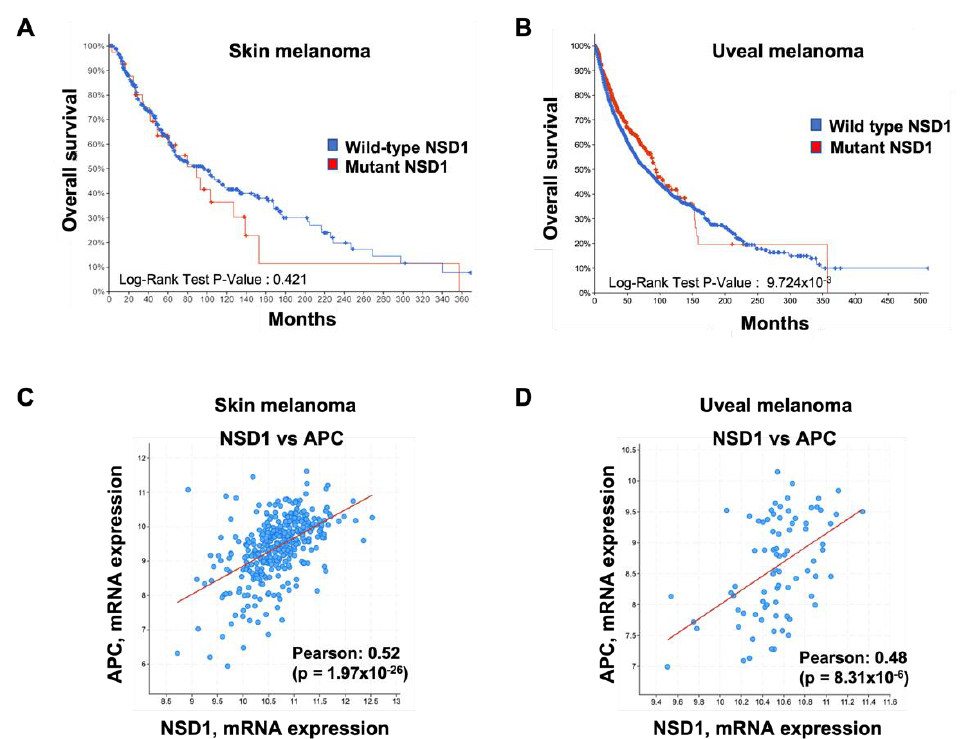
Figure 3. NSD1 mRNA expression in Uveal melanoma vs. Skin melanoma. ( A , B ) Kaplan–Meier curves showing overall survival stratified by NSD1 expression in ( A ) skin melanomas and ( B ) uveal melanomas (SKCM and UM-TCGA, respectively, cBioPortal.org). The log-rank test was used for statistical analysis. ( C ) Scatterplot showing NSD1 and APC mRNA expressions obtained from a skin melanoma cohort (cBioPortal.org). ( D ) Scatterplot showing NSD1 and APC mRNA expressions obtained from a uveal melanoma cohort (cBioPortal.org).